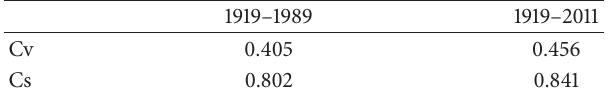
Table 4: Coefficients of variation (Cv) and skewness (Cs) of